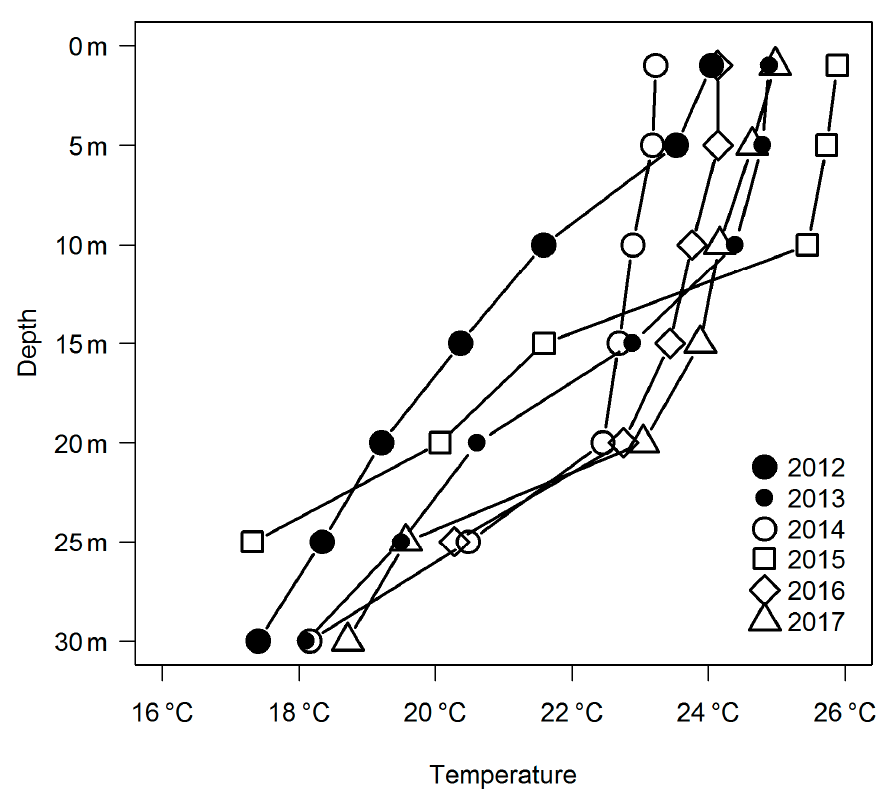
Figure 5. Total time (represented in days) per year that the temperature at 20 m exceeded the different temperature thresholds.